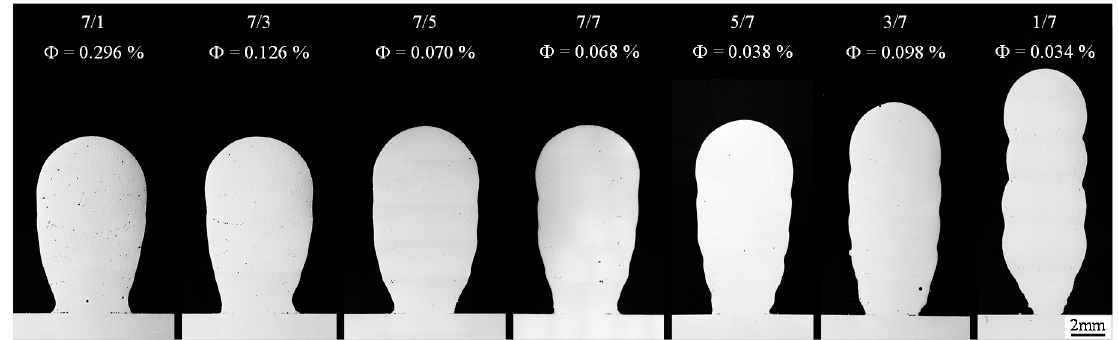
Figure 9. Optically observed porosity ( Φ ) and the final contour of the five-layer walls as a function of the number of positive and negative cycles per arc phase in the CMT-ADV arc mode ( v S = 0.6